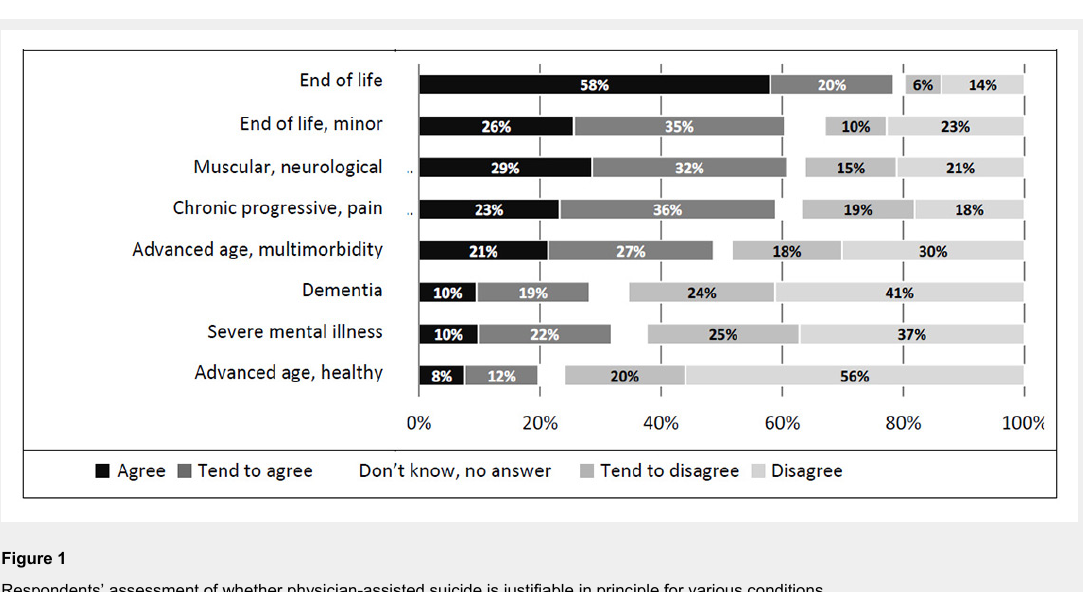
Respondents’ assessment of whether physician-assisted suicide is justifiable in principle for various conditions. Source: Survey of physicians conducted by Büro Vatter/Brauer & Strub; n = 1,318 (weighted). Survey question: Is physician-assisted suicide justifiable in principle in the following situations (assuming the patient has decisional